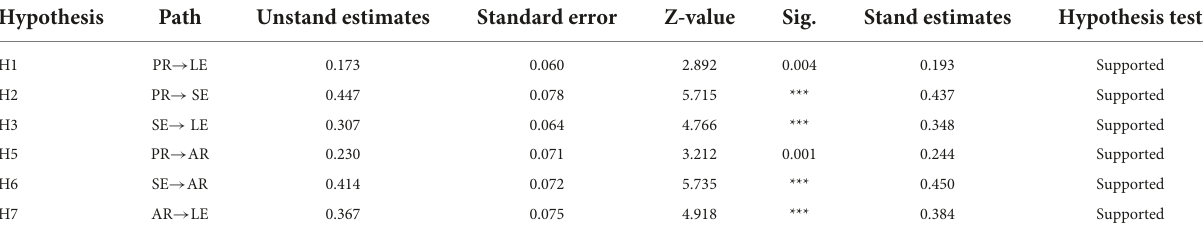
TABLE 6 The test results of path